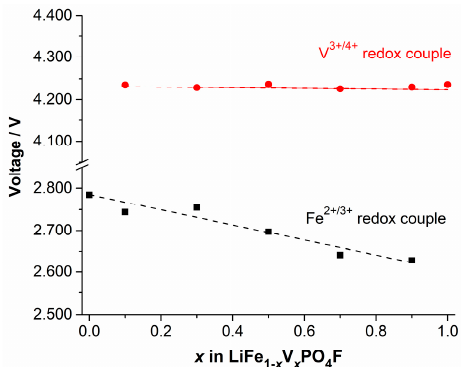
Figure 10. Shifts in midpoints of anodic (Li + -extraction) and cathodic (Li + -insertion) peaks for Fe 2+/3+ and V 3+/4+ couples, exported from Figure 4, as a function of V-content x in LiFe 1– x V x PO 4 F (0 ≤ x ≤ 1).